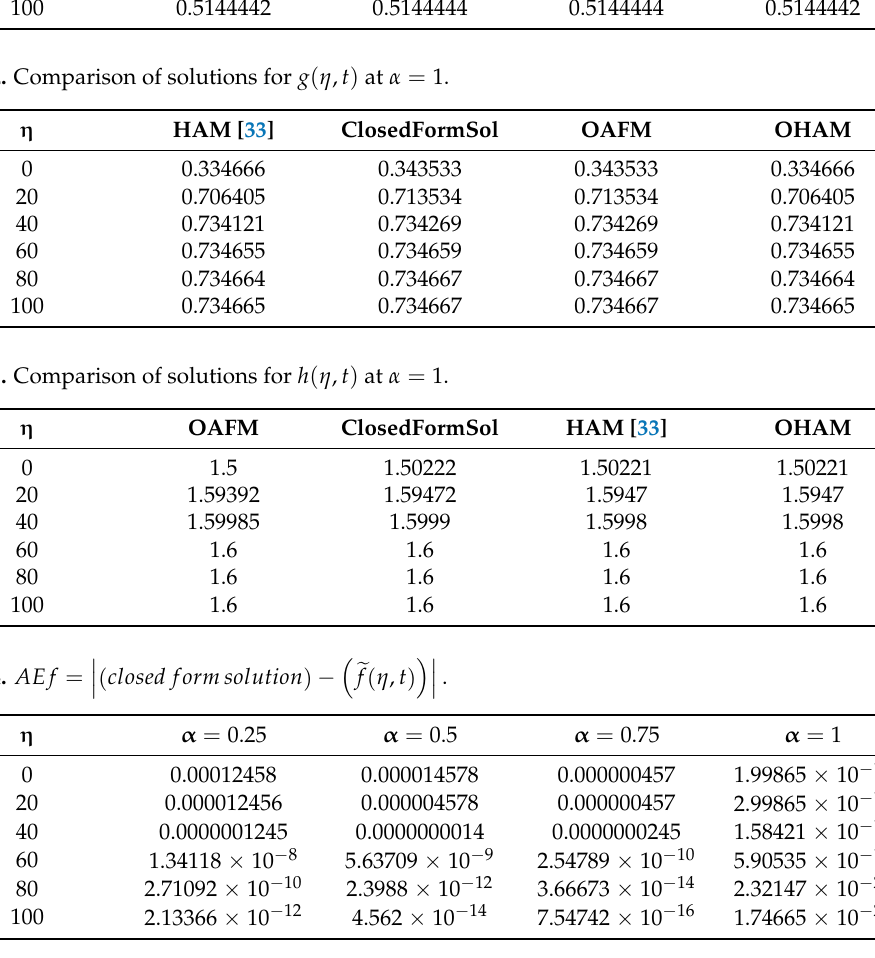
Table 2. Comparison of solutions for g ( η , t ) at α = 1.